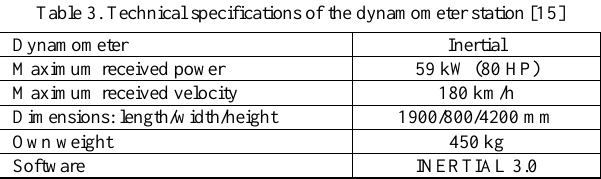
Table 3. Technical specifications of the dynamometer station [15] Dynamometer